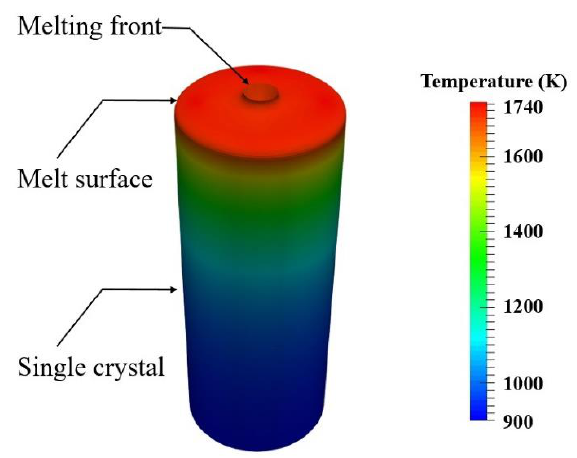
Figure 2. 3D finite volume model for temperature and flow calculation in the melt and crystal. The length of the crystal is 0.3 m. The diameter of the crystal is assumed as 100 mm (4 inch). The hexahedron grids were constructed with the open-source software SALOME.